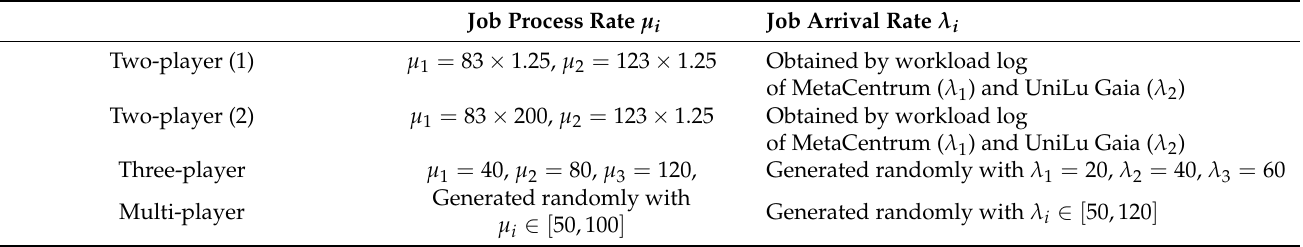
Table 1. Experimental